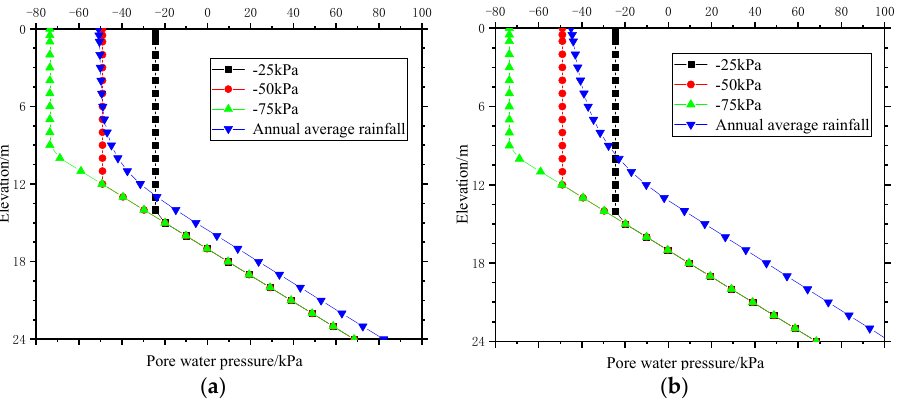
Figure 4. Initial pore pressure distribution. ( a ) Sandy soil. ( b ) Clayey soil.